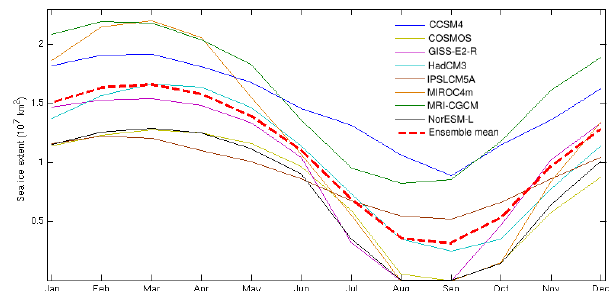
Figure 6. Annual cycle of sea ice extent in the mid-Pliocene sim- ulations for each participating model in PlioMIP Experiment 2 and for the ensemble